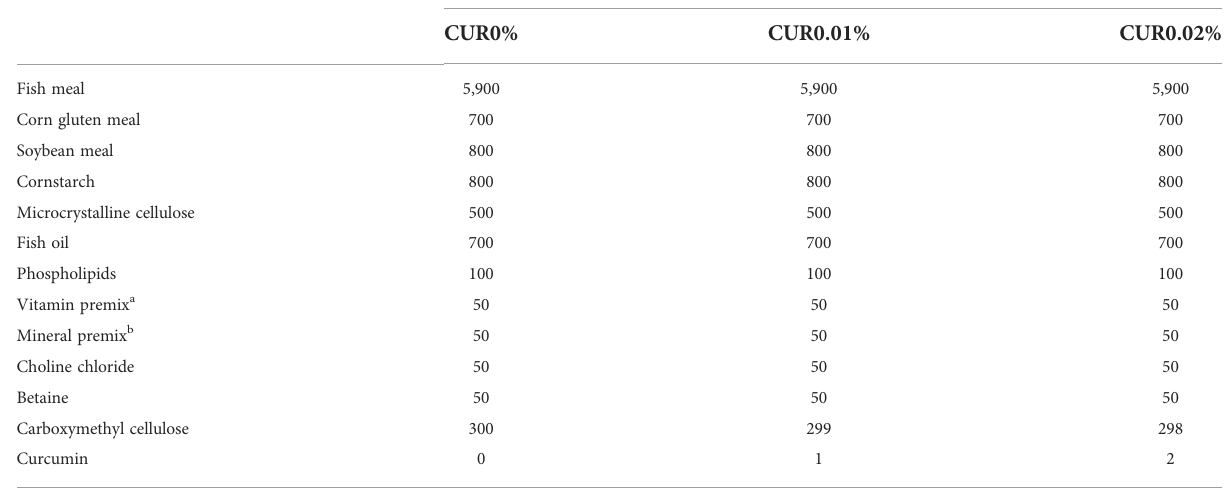
TABLE 1 Formulation and proximate composition of experimental